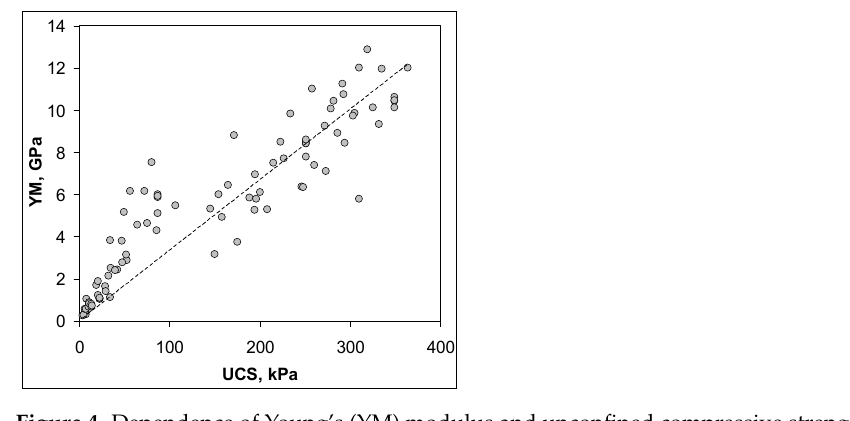
Figure 4. Dependence of Young’s (YM) modulus and unconfined compressive strength (UCS) for all studied aggregates.